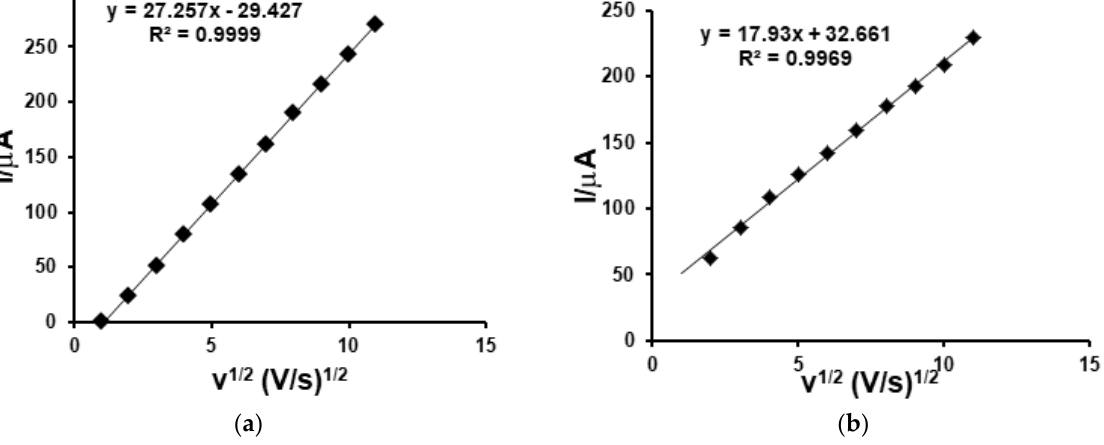
Figure 4. Dependence of cathode peak (I p ) vs. scan rate obtained with CNF/SPE immersed in 10 − 3 M ferulic acid solution ( a ) and 10 − 3 M caffeic acid solution ( b ) in turn.